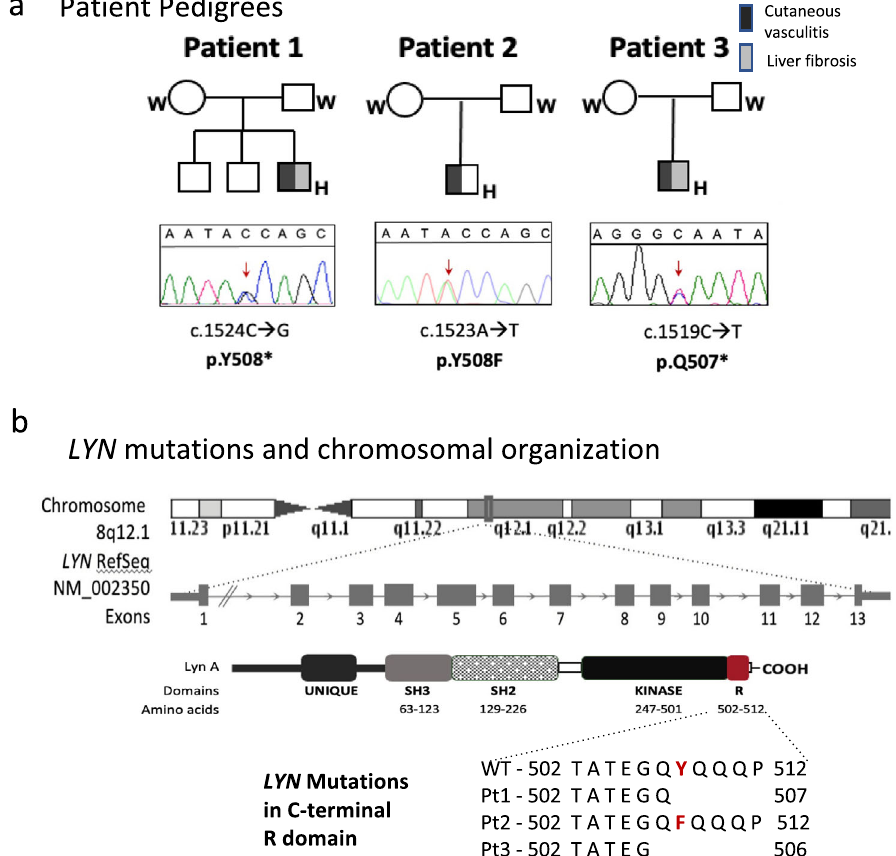
Fig. 1 | Discovery of de novo GOF mutations in LYN as cause of cutaneous vasculitisandliver fi brosis syndrome.a The pedigrees show a denovo variant in LYN in each of the three patients. Squares and circles represent male and female family members, respectively; solid symbols and open symbols indicate affected and unaffected family members, respectively. b In Patient 1 and Patient 3 the